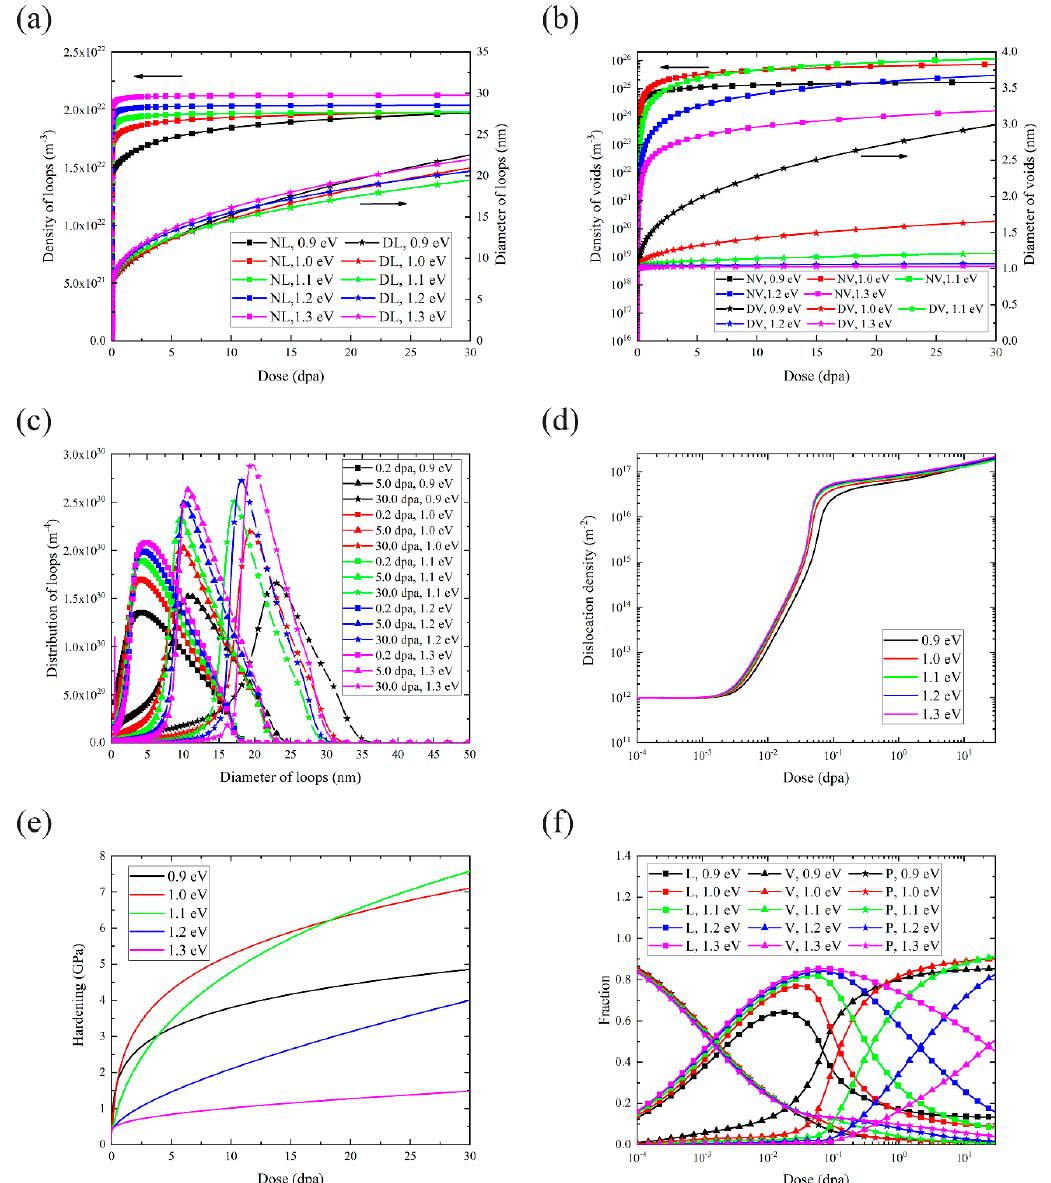
Figure 5. Rate theory calculations with various migration energy of vacancy. ( a ) Number density and diameter of loops. ( b ) Number density and diameter of voids. ( c ) Distribution of loops at 0.2 dpa, 5 dpa and 30 dpa. ( d ) Dislocation density. ( e ) Hardening. ( f ) Contribution of loops (L), voids (V) and precipitates (P) to hardening.